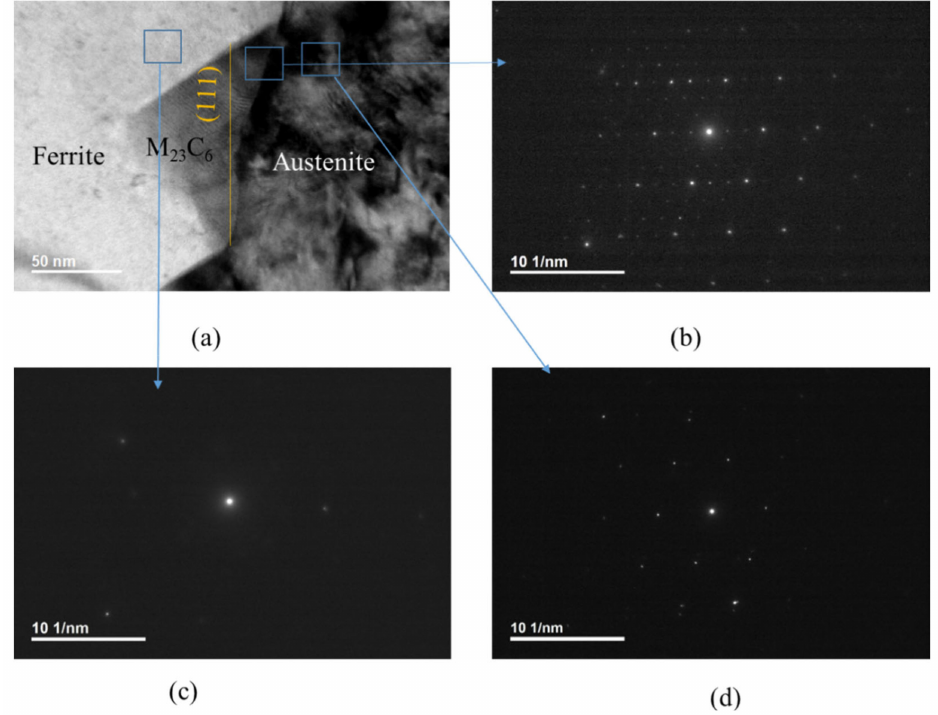
Figure 2. TEM image and SAED pattern: ( a ) a bright-field TEM image; ( b ) SAED patterns of M 23 C 6 carbide together with austenite; ( c ) SAED patterns of ferrite; ( d ) austenite. All micrographs were obtained at B = [011] of